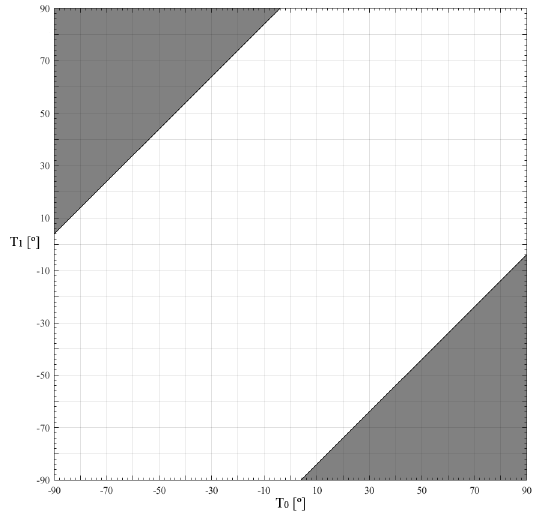
Figure 2. Feasible manufacturing fiber angles domain, in white.